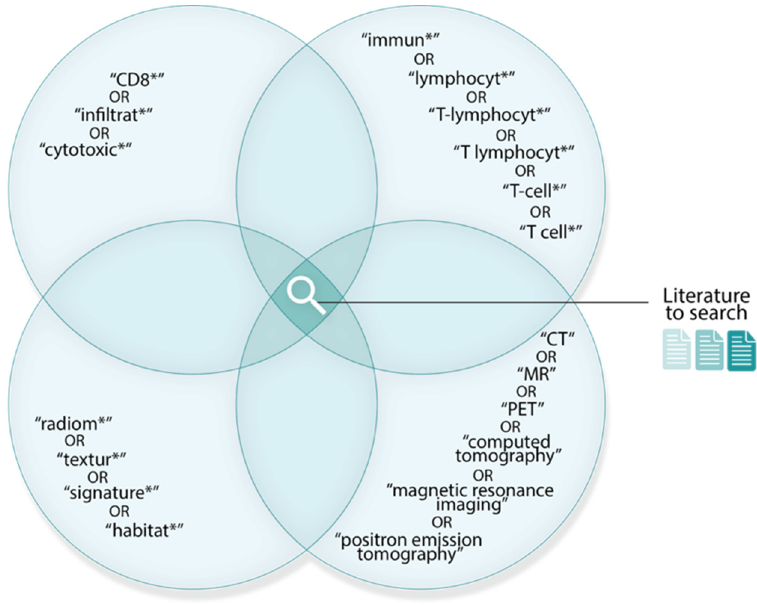
Figure 2. Boolean search used to retrieve relevant literature. Literature must contain at least one term from each set. Overlaps between sets indicate the Boolean AND operator. Search term truncations are denoted by an asterisk